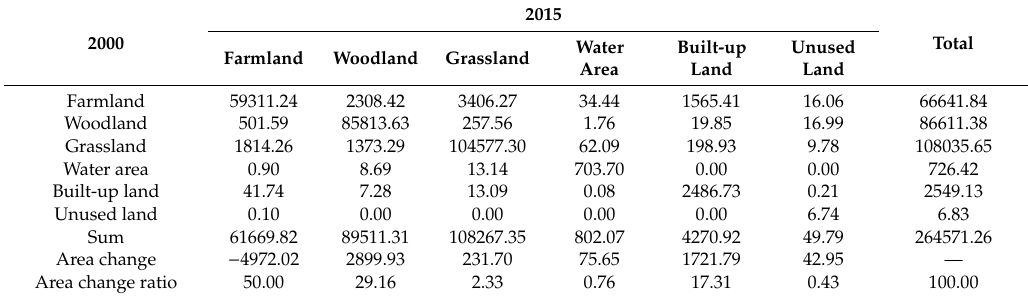
Table 5. Land use type change transfer matrix in Shangzhou district